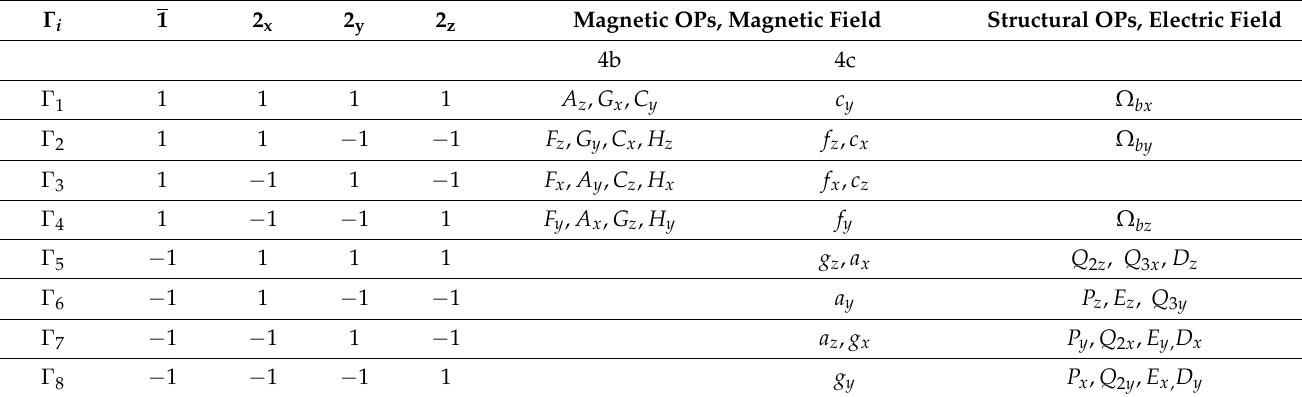
Table 2. Irreducible representations of the Pnma symmetry group. Magnetic OPs, Magnetic Field Structural OPs, Electric